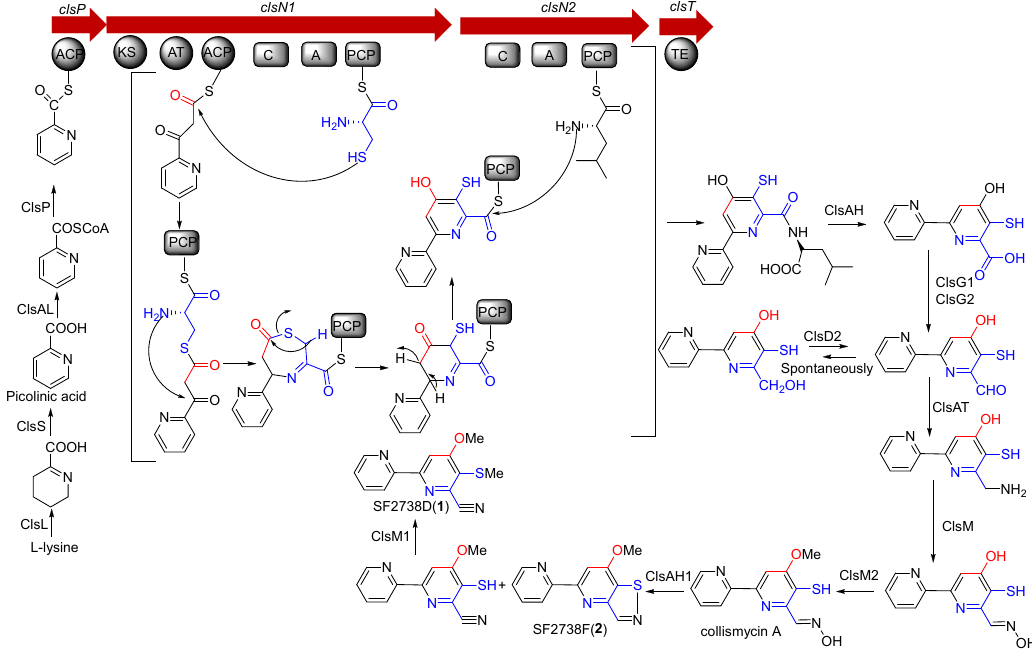
Figure 4. Proposed biosynthetic pathway of SF2738D and SF2738F in S. griseus SCSIO PteL053.